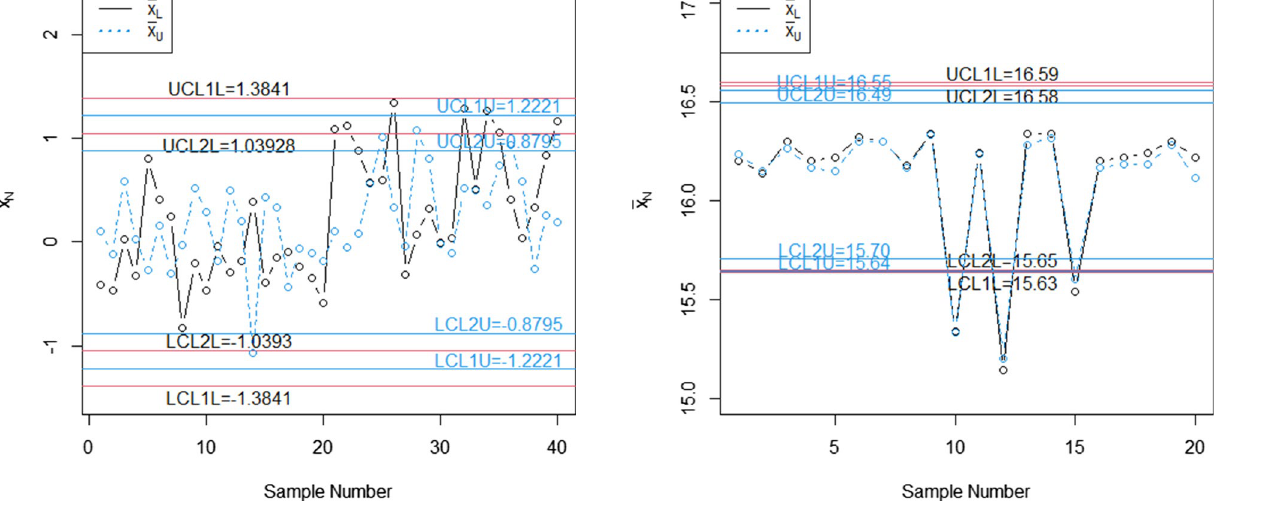
Fig. 4 The proposed control for the real